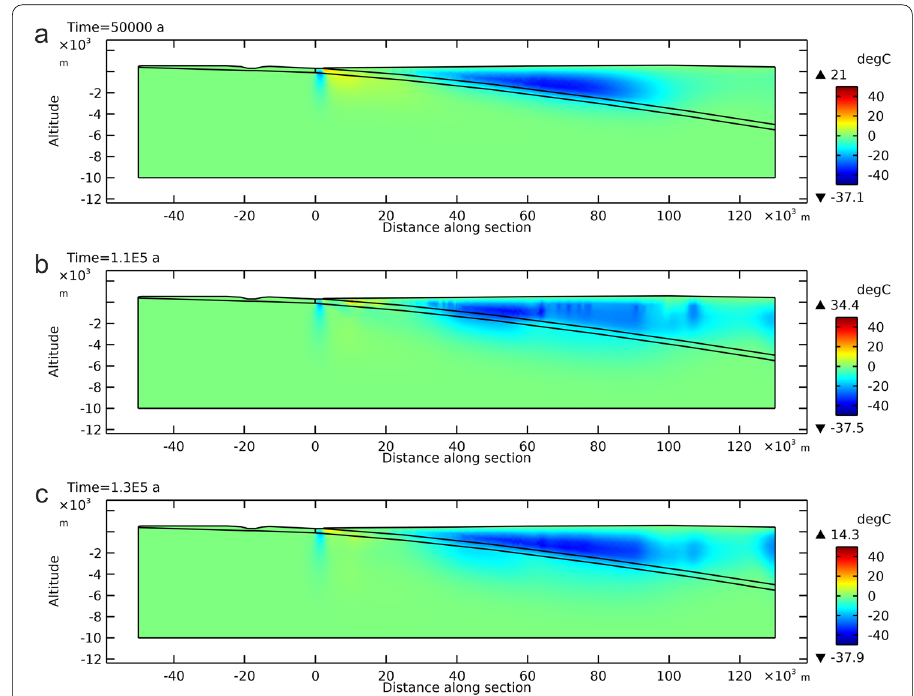
Fig. 14 Temperature difference between both scenarios of high and low Malm permeabilities under paleoclimatic conditions (i.e. difference between model runs E and D introduced in Fig. 3): a 80 ka ago (time 50,000 a), b 20 ka ago (time =